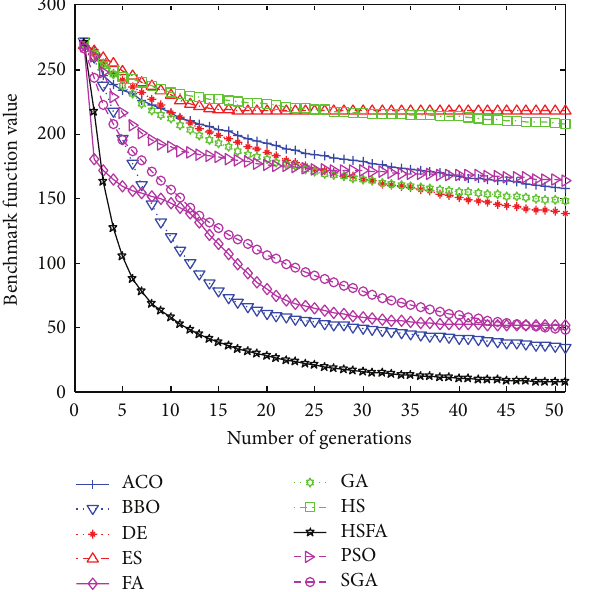
Figure 1: Performance comparison for the F26 Rastrigin function.